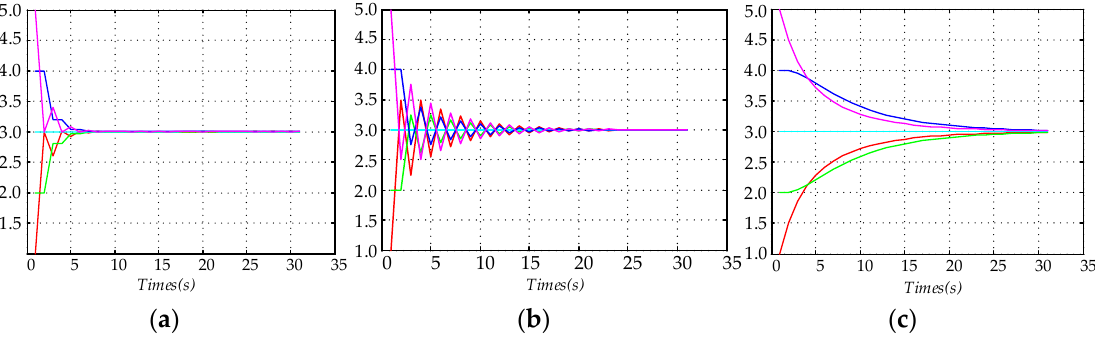
Figure 10. Converging speed comparison under different constant weights, a. ( a ) Consensus dynamic at a = 2/5; ( b ) Consensus dynamic at a = 1/2; ( c ) Consensus dynamic at a = 1/10.